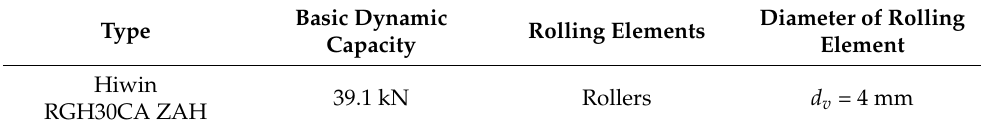
Figure 6. The functional sample.